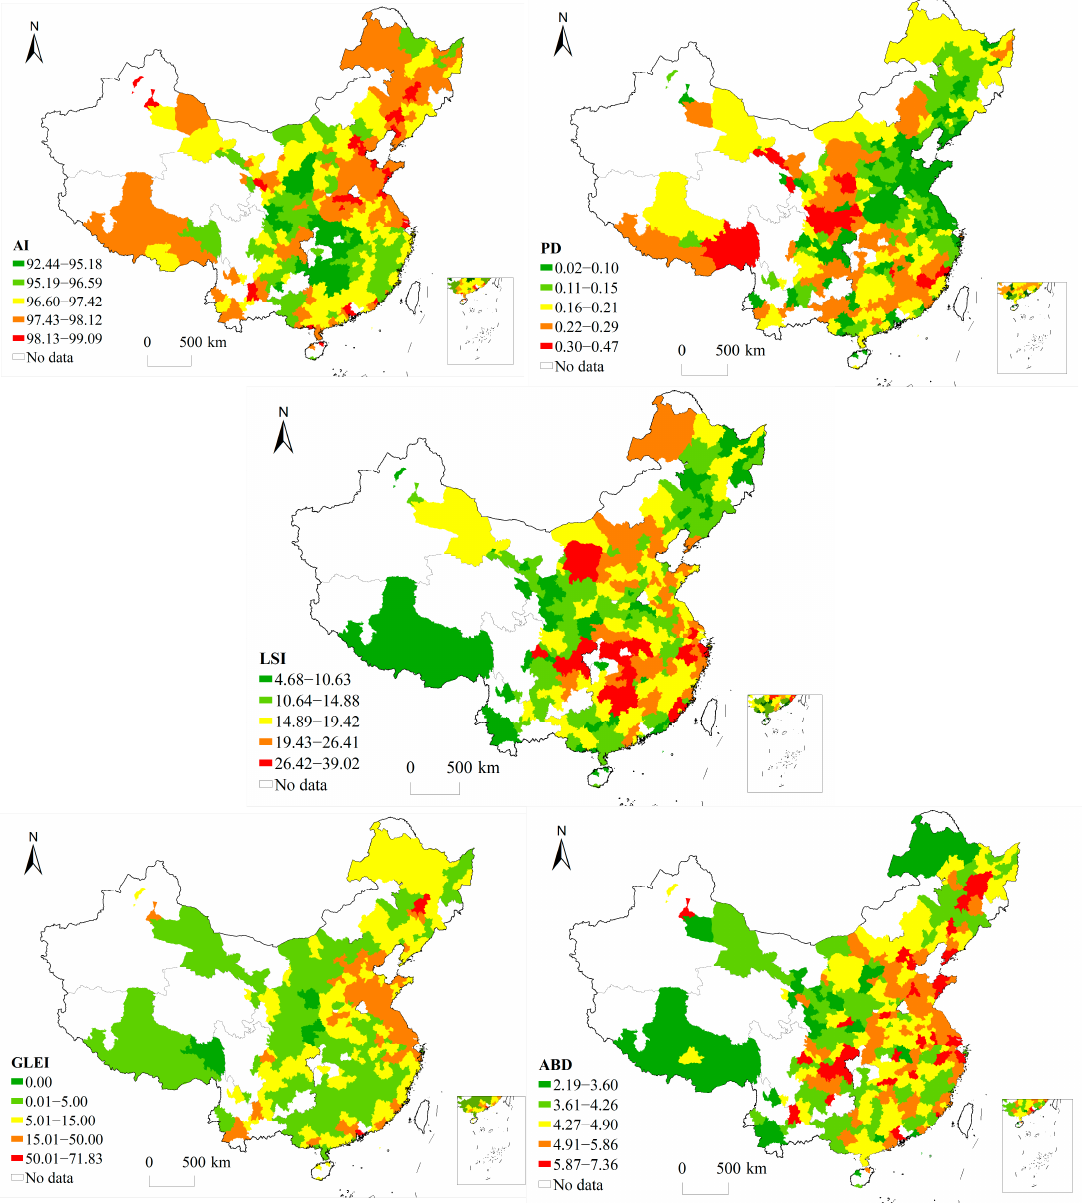
Figure 6. Distribution of values of 5 urban morphological indicators.